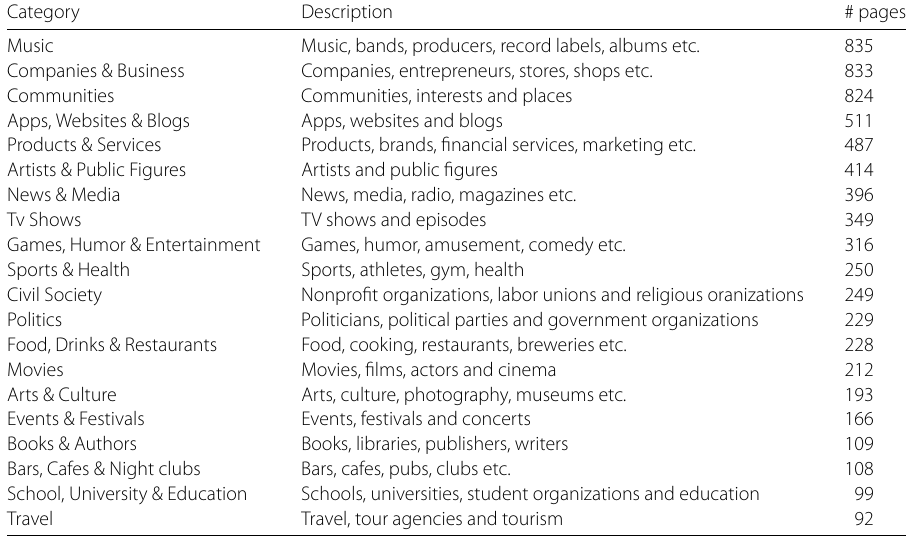
Table 1 Description and number of pages for the 20 Facebook categories